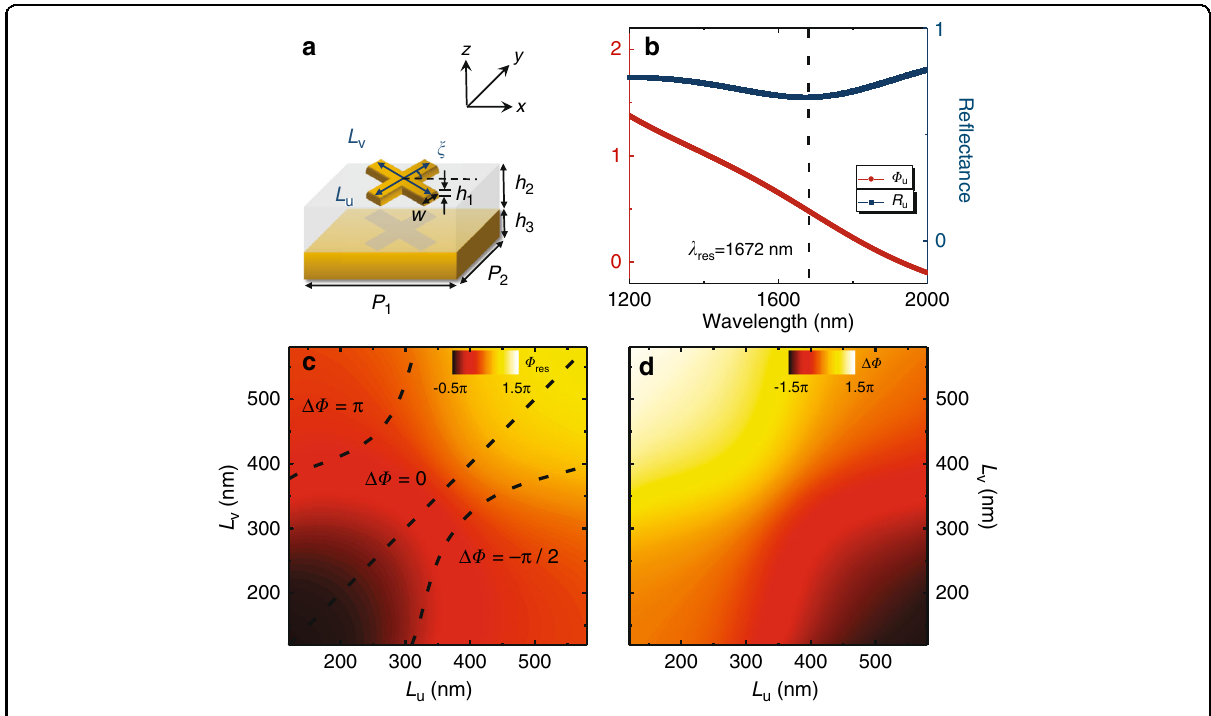
Fig. 3 Meta-atom design. a Schematic of the designed MIM meta-atoms with varying L u and L v and fi xed h 1 ¼ 30nm ; h 2 ¼ 180nm ; h 3 ¼ 125nm, w ¼ 120nm, and P 1 ¼ P 2 ¼ 600nm. b FDTD-simulated spectra of re fl ectance R u and phase Φ u for the meta-atom with L u ¼ 367nm and L v ¼ 120nm under ~ E == ^ u polarized incident light. Phase diagrams of c Φ res and d ΔΦ versus L u and L v obtained by FDTD simulations at a wavelength of